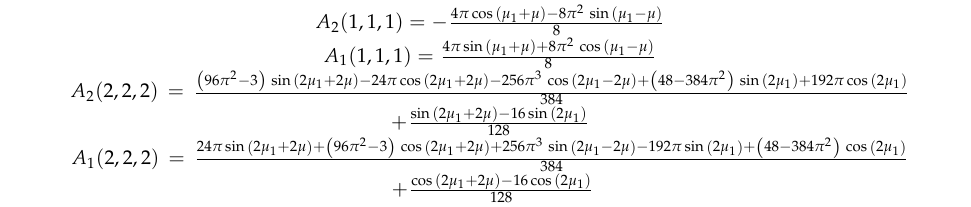
Table 2. Some expressions for A 1 ( · , · , · ) and A 2 ( · , · , · )